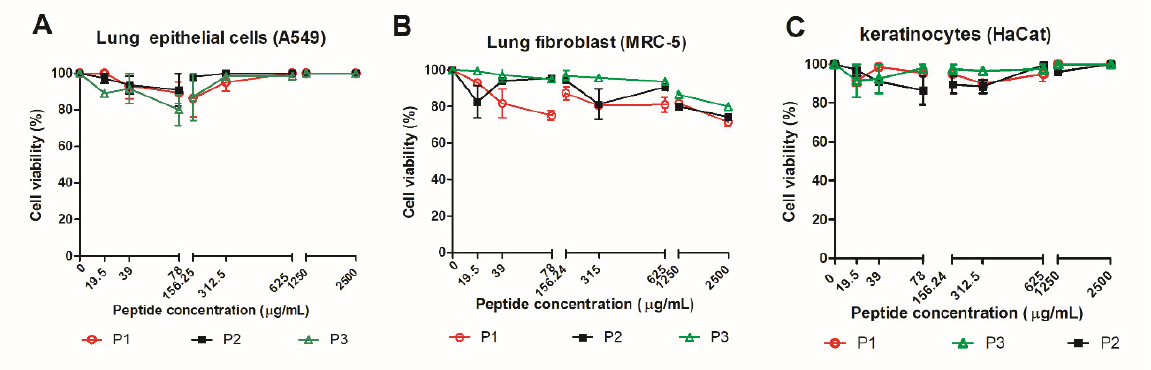
Figure 2. Cytotoxicity of 14-3-3 peptides evaluated in lung epithelial cells ( A ), lung fibroblasts ( B ), and skin keratinocytes ( C ), using the resazurin method. Data expressed as mean ± standard deviation of two biological replicates and two independent